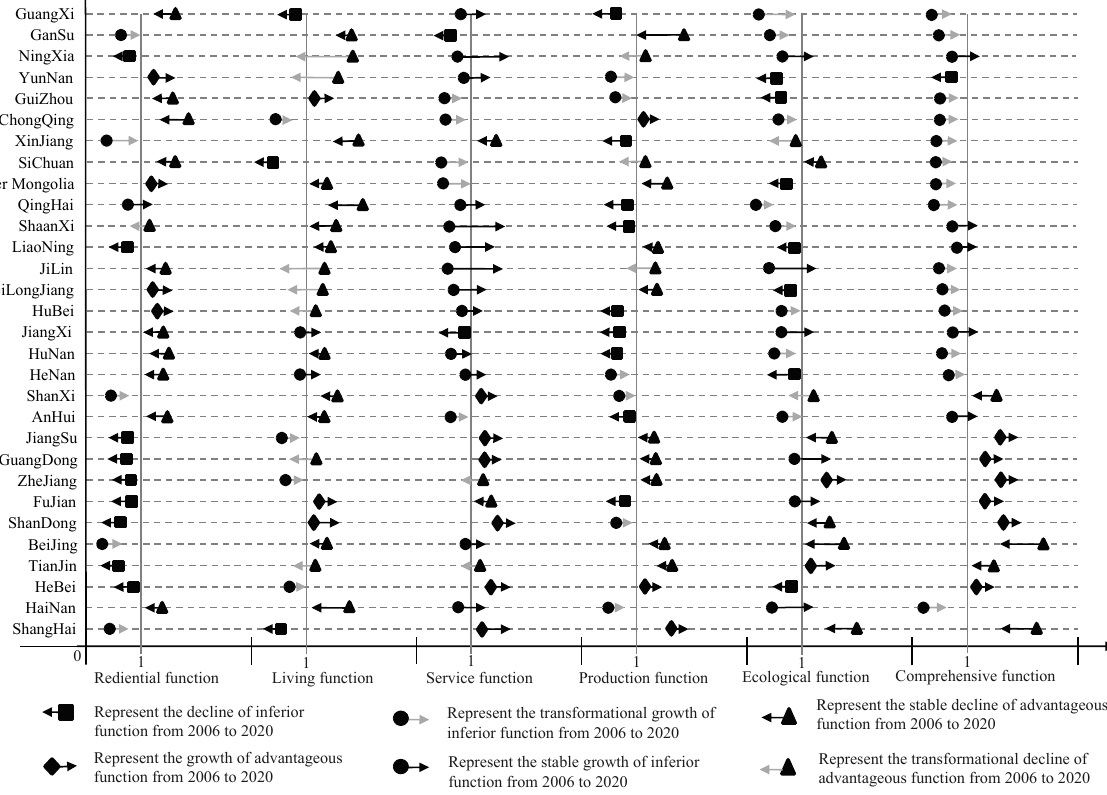
Figure 5. Dominance indexes of and changes in various functions of rural residential land in different provinces of China.